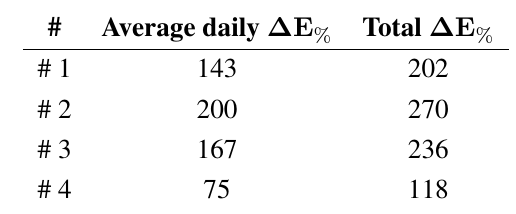
/m 2 ) for an incoming tide (same telemac